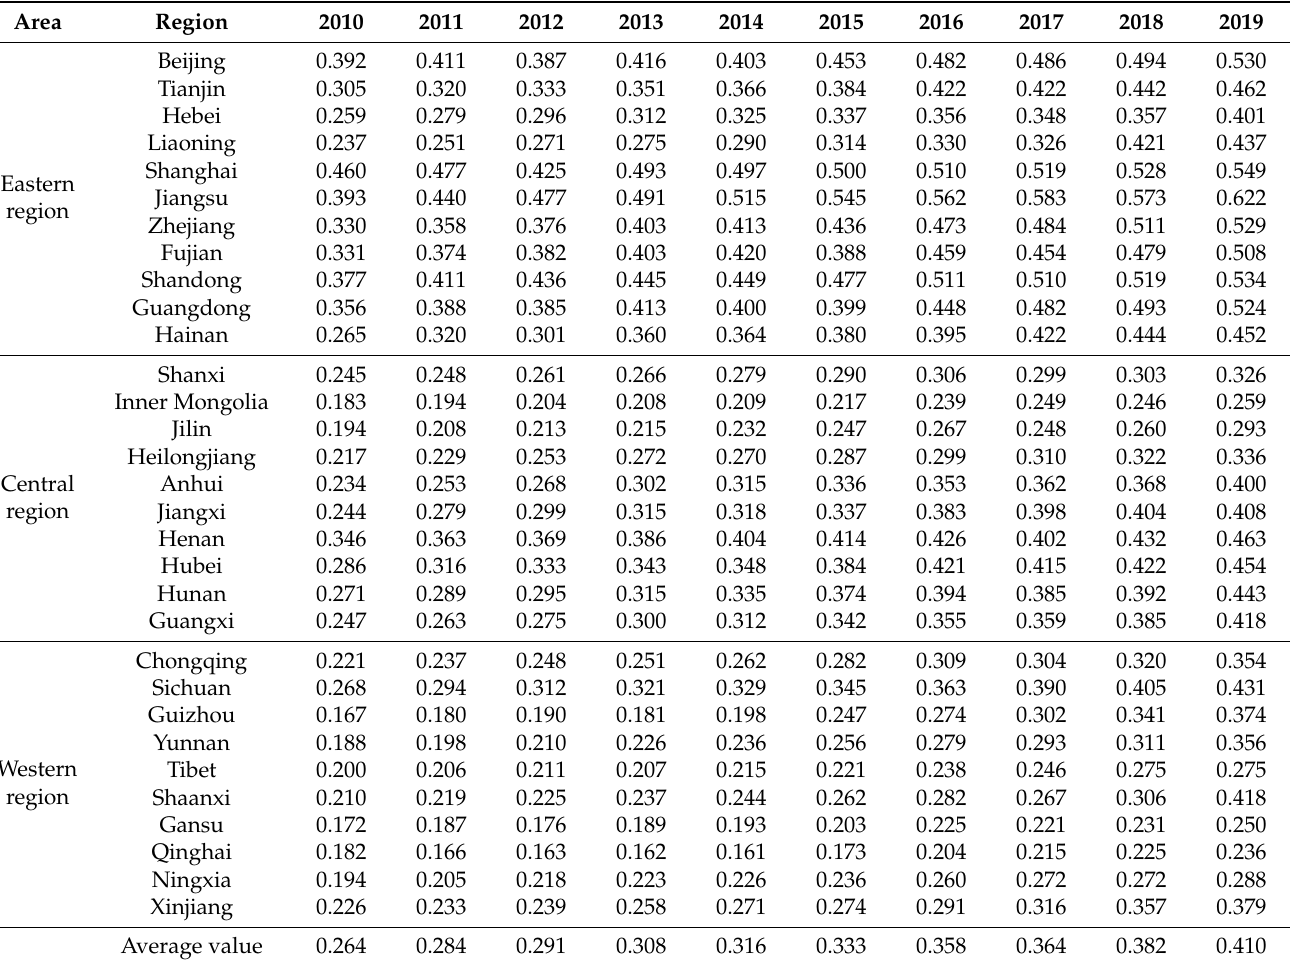
Table 4. Rural resilience level values by region,